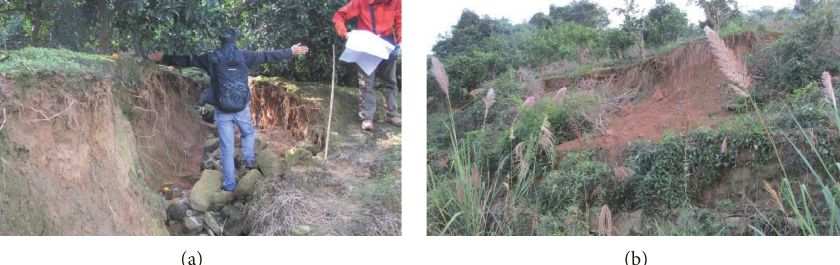
Figure 12: Large deformation observations in the Baishuihe landslide site. (a) Great fissure at the intermediate platform. (b) Small collapse at the top section of the